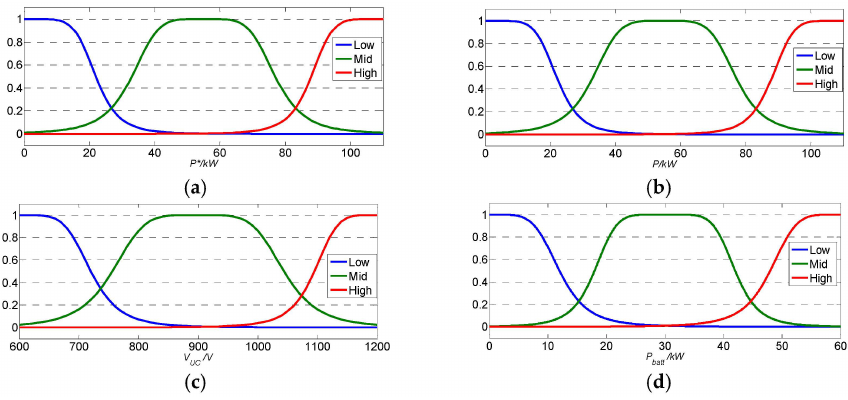
Figure 19. Input and output membership functions. ( a ) P *; ( b ) P ; ( c ) V UC ; ( d ) P batt .